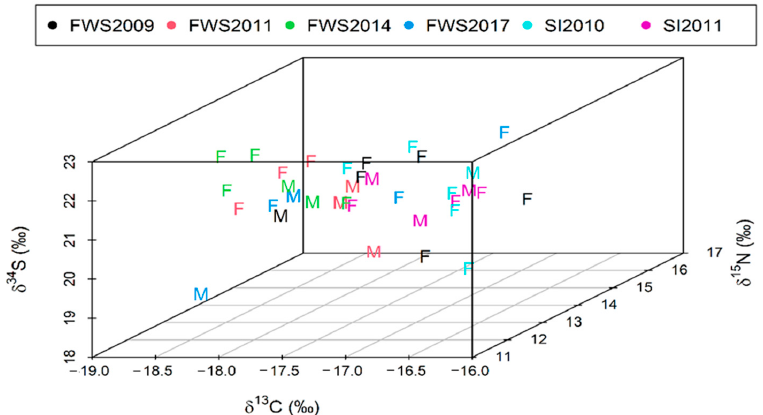
Figure 5. Carbon, nitrogen, and sulphur ( δ 1 3 C , δ 15 N and δ 3 4 S ) stable isotope triplot of long-finned pilot whale ( Globicephala melas edwardii ) skin samples. Males are represented by “M” and females by “F”. Data are presented by stranding event as indicated by colour in the legen3.3. GAM Analy- sis .